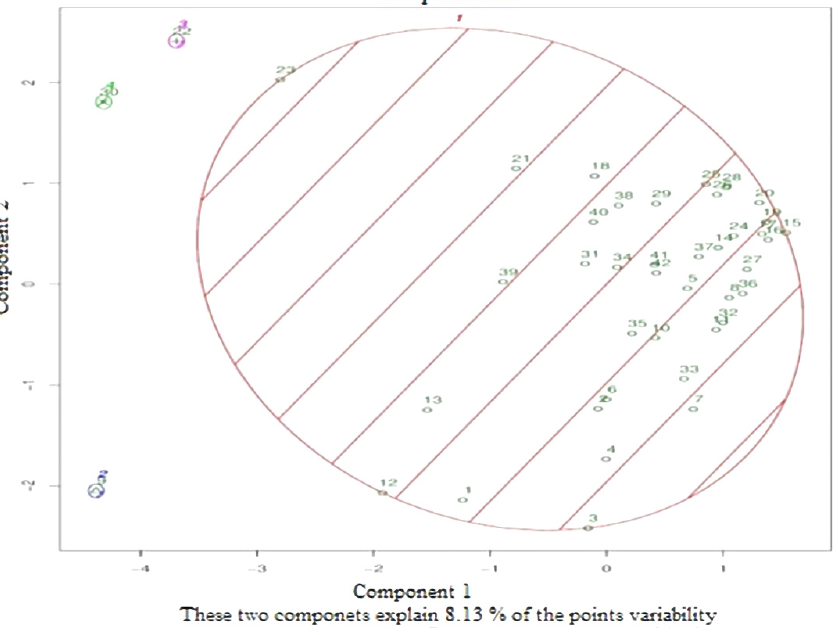
Fig. 11. K -Medoids clustering using unique words for relatively big document with K ¼ 4